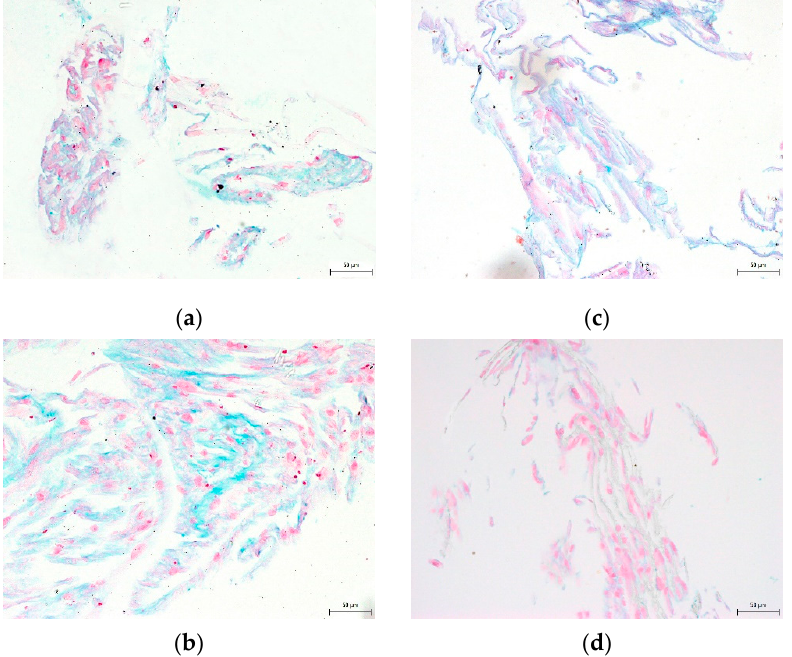
Figure 9. Detection of acid mucopolysaccharides in the extracellular chondrogenic mass of DPSCs after 3-week cultivation in a chondrogenic differentiation medium. After histological staining using Alcian blue, the acid mucopolysaccharides appear as turquoise areas: ( a ) 10% DMSO cryomedium; ( b ) 3% DMSO cryomedium; ( c ) 3% DMSO + 0.1% HMW-HA cryomedium; ( d ) non-differentiated DPSCs. Scale bar 50 µm.